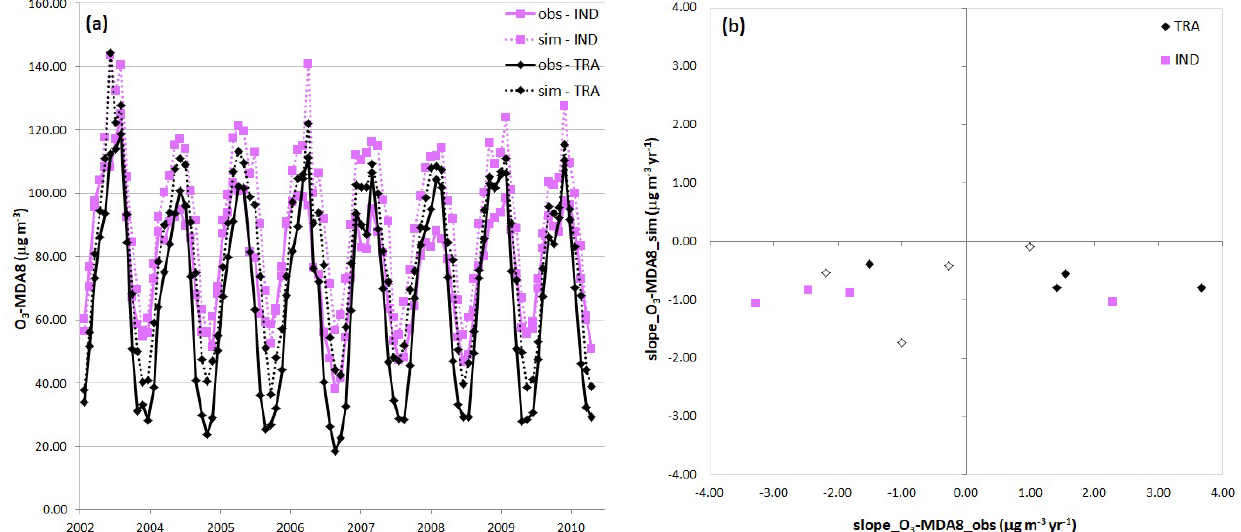
Figure 13. (a) Observed (solid line) and simulated (dashed line) monthly means of O 3 MDA8 concentrations (in µgm − 3 ) for all the traffic (black diamond) and industrial (pink square) monitoring stations. (b) Scatter plot of observed and simulated slopes (in µgm − 3 yr − 1 ) for MDA8 in the period April–September at each individual station. Sites where significant slopes are estimated for both observations and simulated data are indicated with a filled